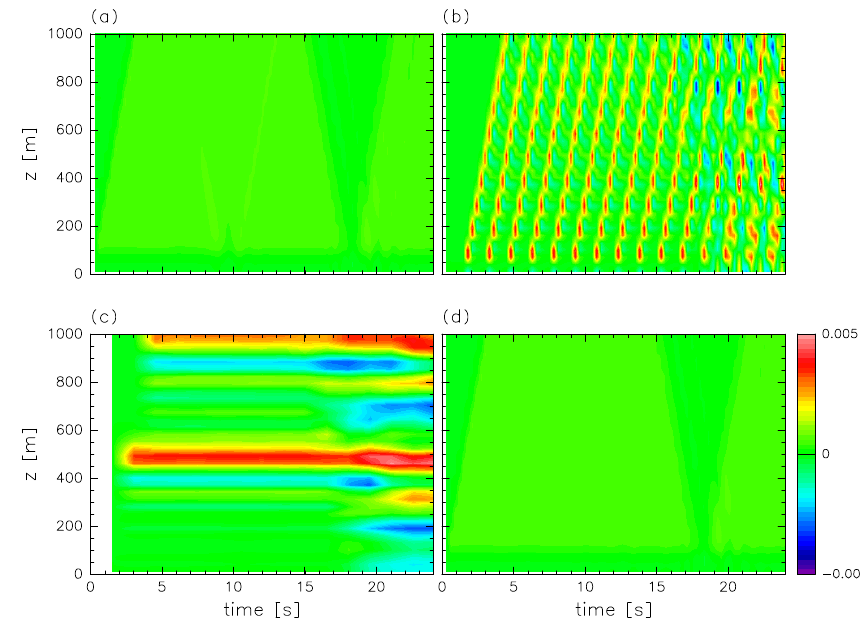
Figure A2. Time–height section of horizontal mean vertical velocity in runs where (a) (cid:49)t dyn = (cid:49)t phys = 0 . 03s and (cid:49)t output = 0 . 3s, (b) (cid:49)t dyn = 0 . 03s, (cid:49)t phys = 1 . 5s, and (cid:49)t output = 0 . 3s, and surface flux is added at large time step intermittently, (c) same as (b) but (cid:49)t output = (cid:49)t phys = 1 . 5s, and (d) same as (b) but surface flux is added at small time